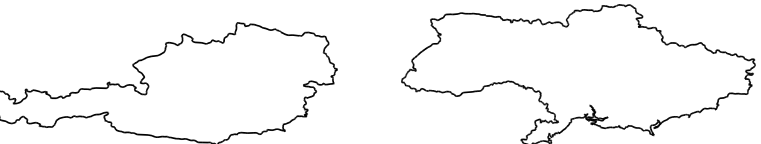
Figure 10. Examples of country-based polygons from Natural Earth [11].